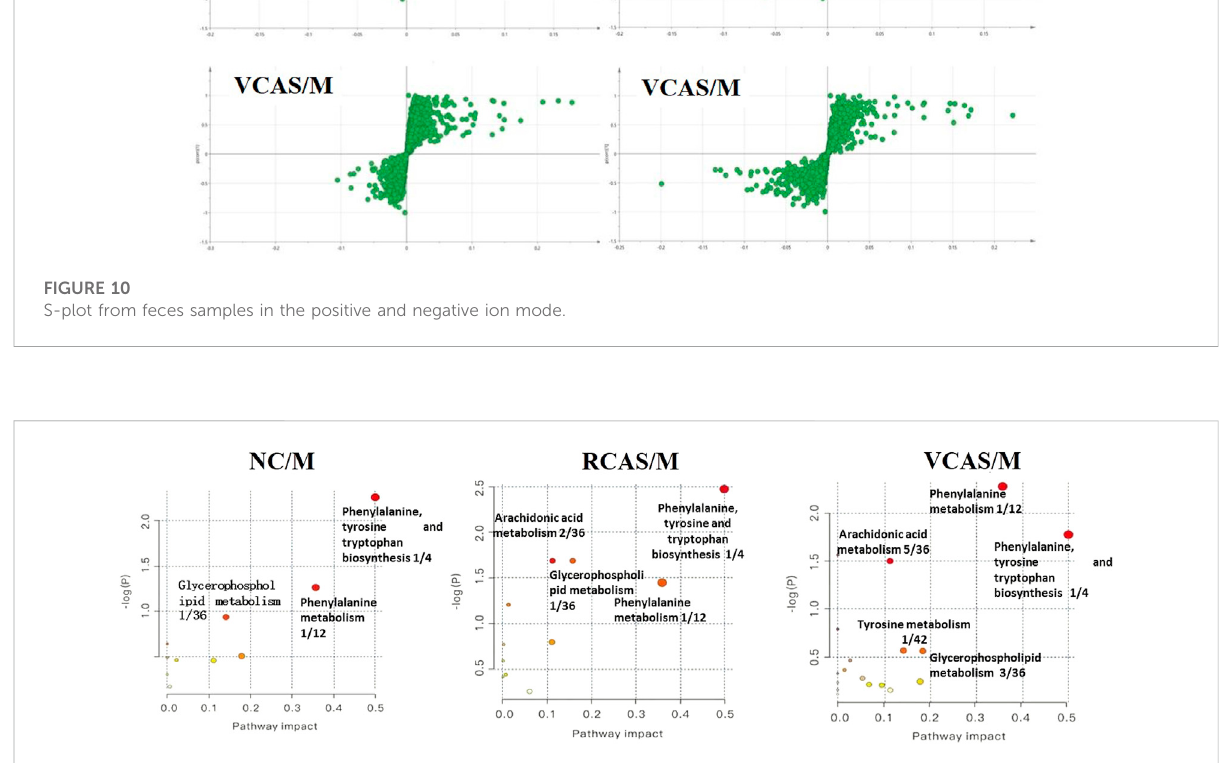
FIGURE 11 Enrichment results of metabolic pathways between feces